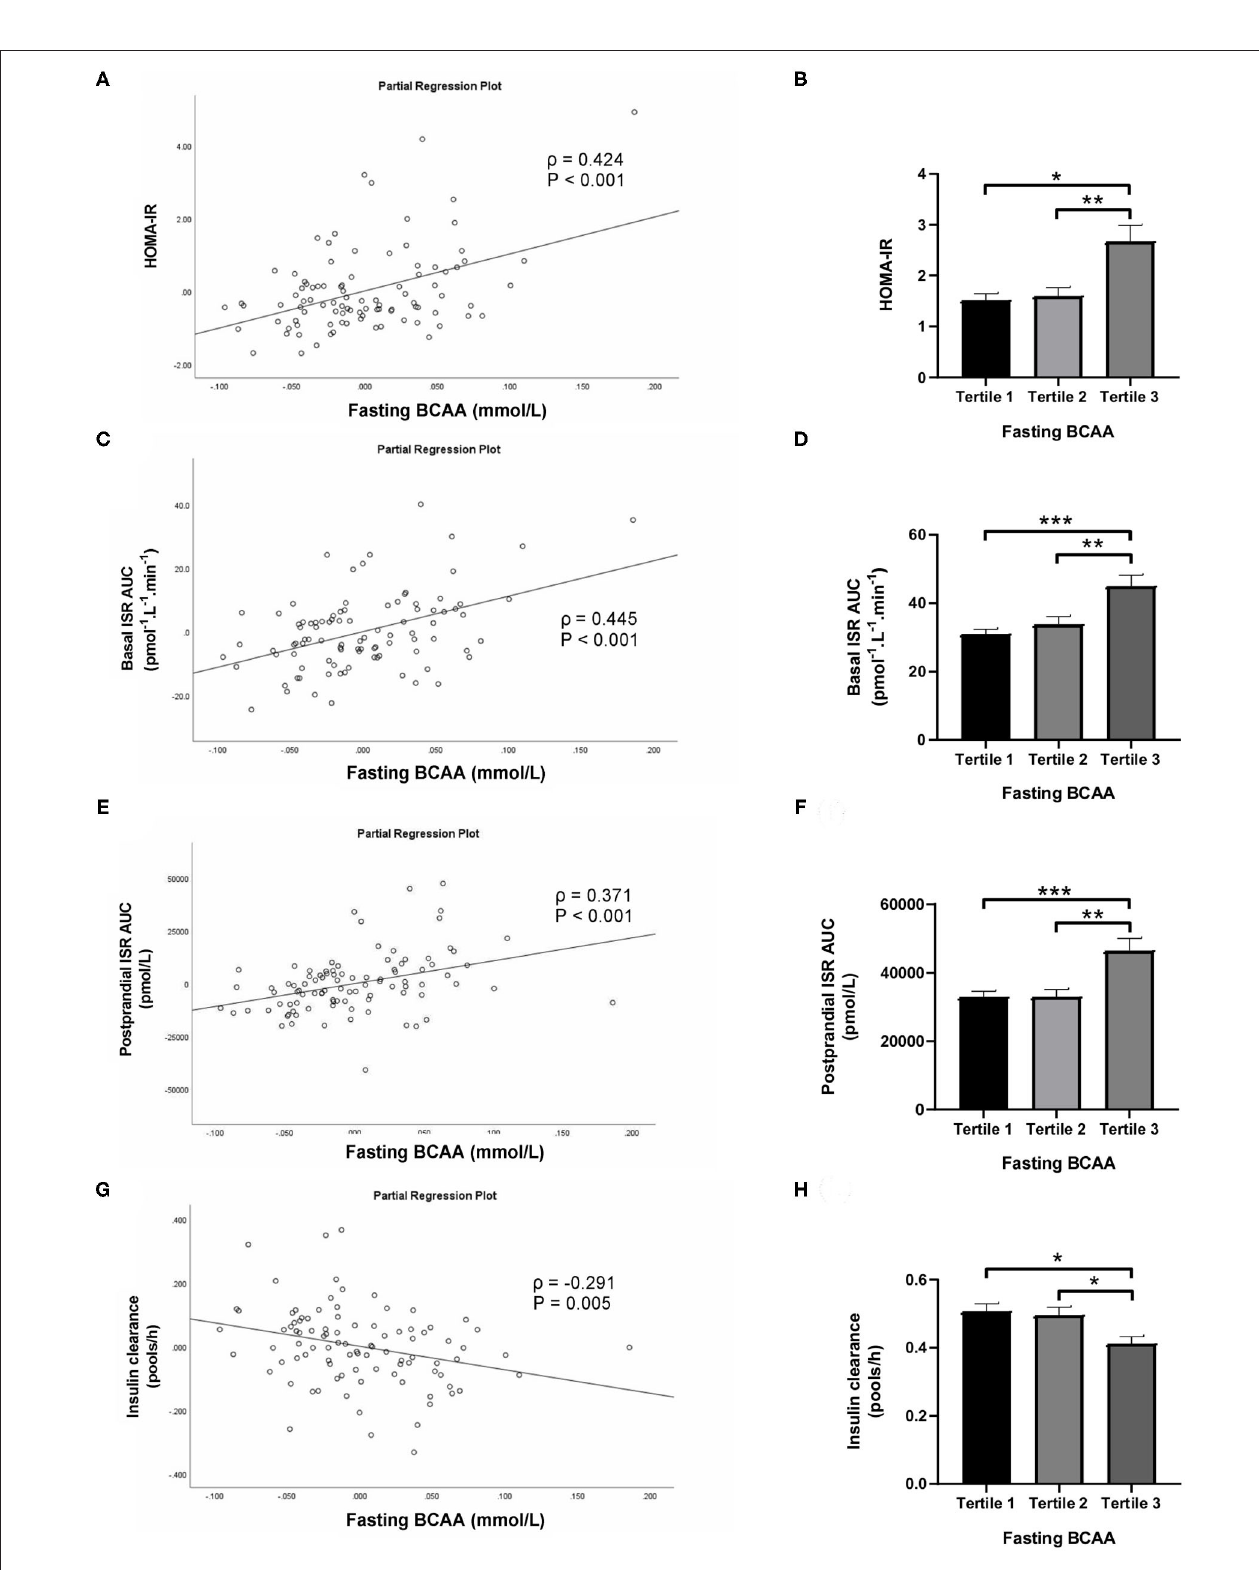
FIGURE 4 | Homeostasis Model Assessment of Insulin Resistance (HOMA-IR; A,B ), basal insulin secretion rate (ISR; C,D ), total postprandial ISR area under the curve (AUC; E,F ) and insulin clearance (G,H) in relation to fasting BCAA concentration (left) and in subjects stratified to tertiles of fasting BCAA concentration (right). Data are mean ± SEM; n = 30–33 per group. Continuous analyses are depicted as partial correlation plots and differences among tertiles are determined by one-way ANOVA. All analyses have been adjusted for sex and BMI. Corresponding values are significantly different between groups (Šidák-corrected): * P < 0.05, ** P < 0.01, *** P <